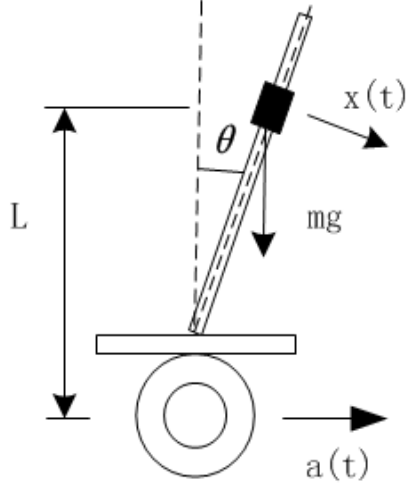
Figure 6. Force analysis of robot model.